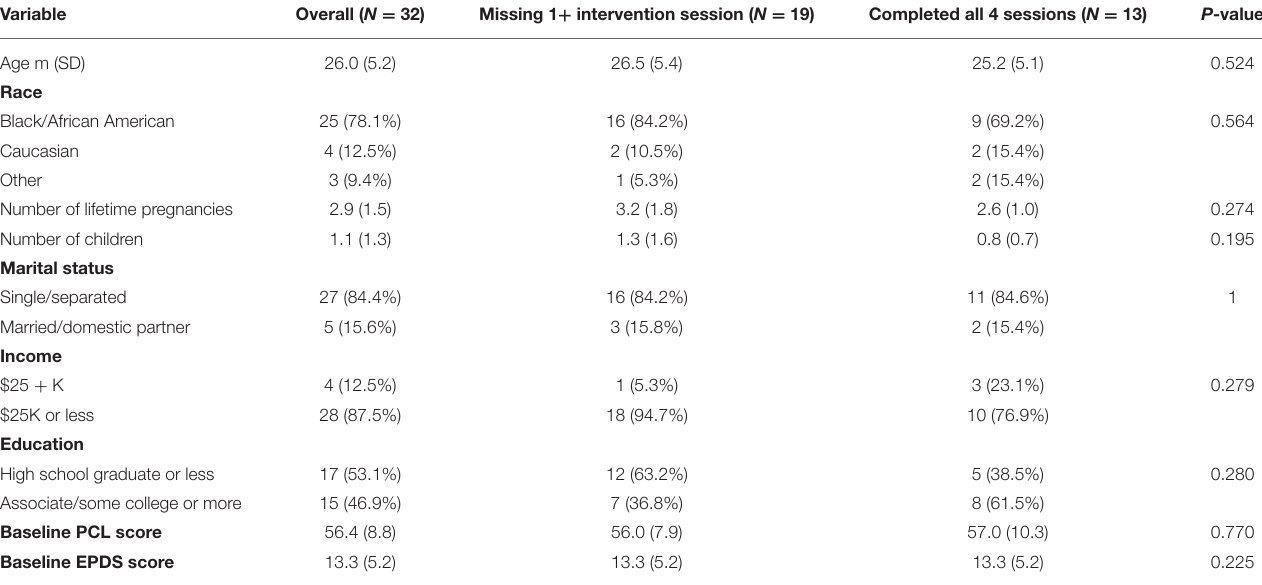
TABLE 1 | Baseline demographic characteristics for all participants and by